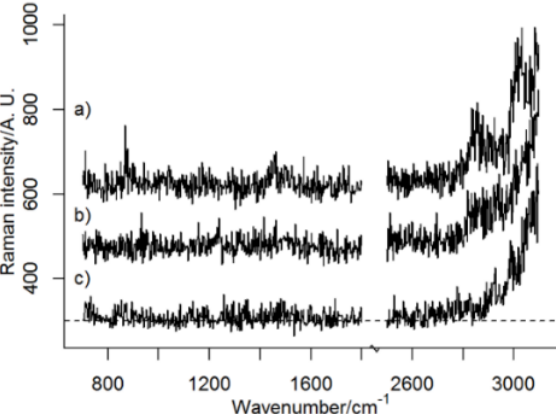
Figure 4. Raw spectra from ( a ) a pixel centered at the largest particle agglomerate; ( b ) a pixel from the cell in a region free from particles; and ( c ) the background (substrate). All pixels are from the 100 nm image. An intensity offset have been added to the spectra.